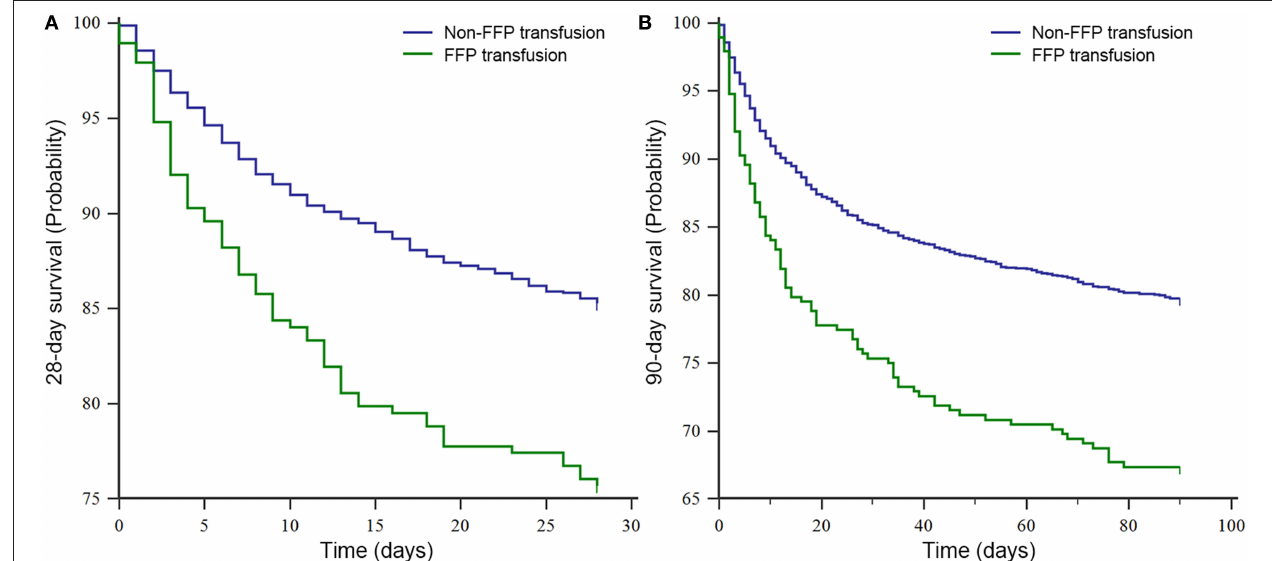
FIGURE 2 | The Kaplan–Meier survival analysis of sepsis cohort in the MIMIC III database. (A) 28-day survival curve and (B) 90-day survival curve. FFP, fresh frozen plasma; and MIMIC III, Medical Information Mart for Intensive Care III.